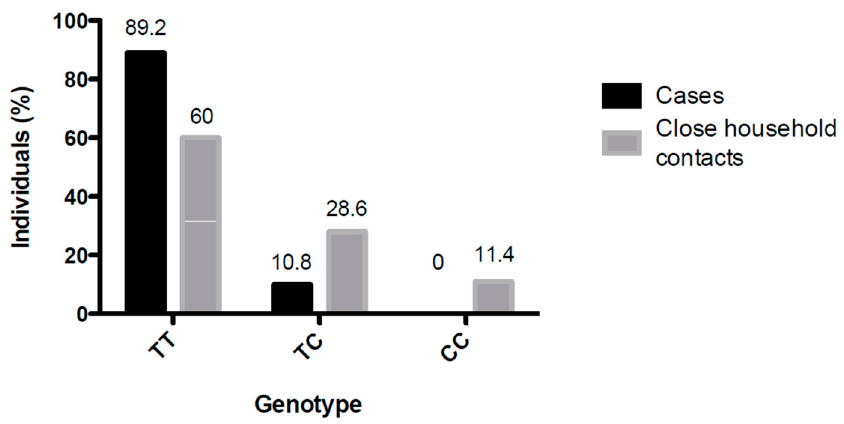
Figure 2. SNP rs5918 genotype distribution among cases and close-household contacts. The cases and household contacts were grouped according to the SNP rs5918 genotype. The total number of each population was defined as 100%, and the percentage of individuals according to each genotype was indicated ( p > 0.05). Table 1. SNP rs5918 genotypes and risk variable distribution among ANDV-infected patients and uninfected close-household individuals.